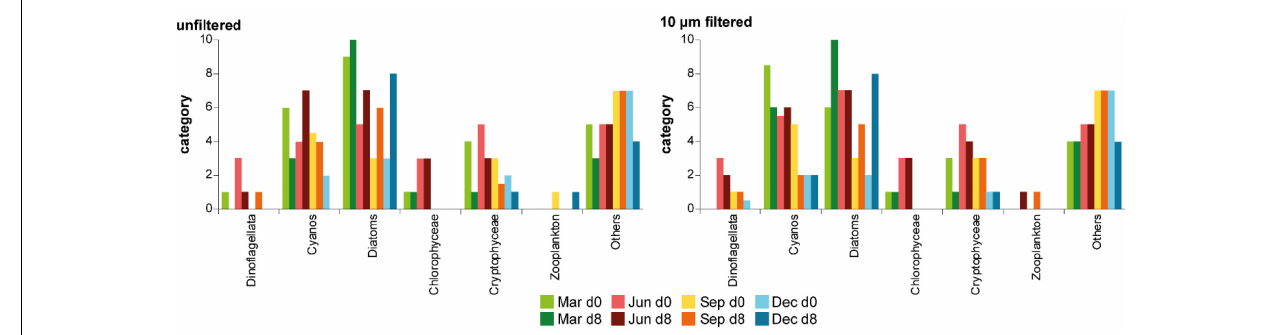
FIGURE 3 | Biological community (median of triplicates) in the “unfiltered” and “10 µ m” treatment; for the definitions of categories, see Table 2 , Cyanobacteria (Cyanos) and Diatoms are summed and shown as stacked bars, Mar, March; Jun, June; Sep, September; Dec, December; d0, day 0; d8, day 8.